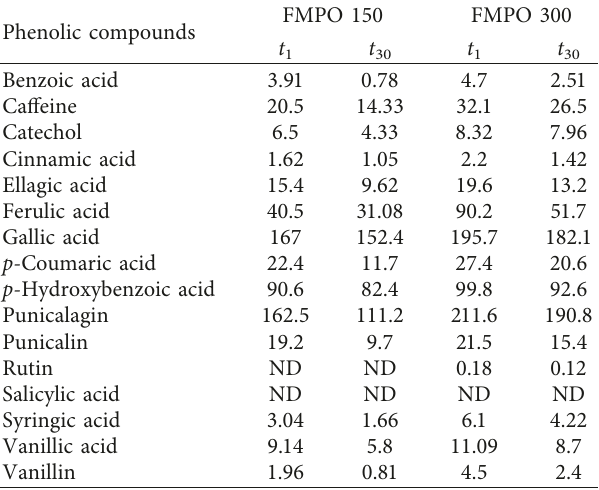
Table 5: HPLC analysis of phenolic compounds ( μ g/g) for FMPO 150 and FMPO 300 during storage.